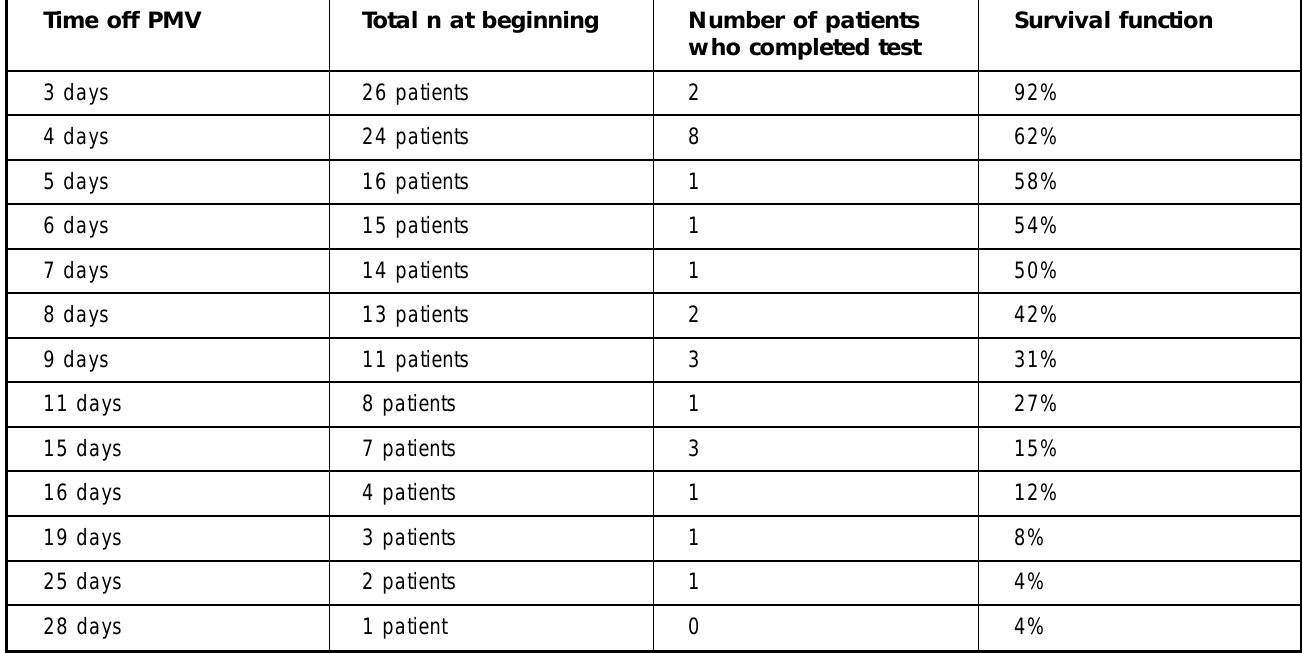
Table 6: Kaplan-Meier survival estimate